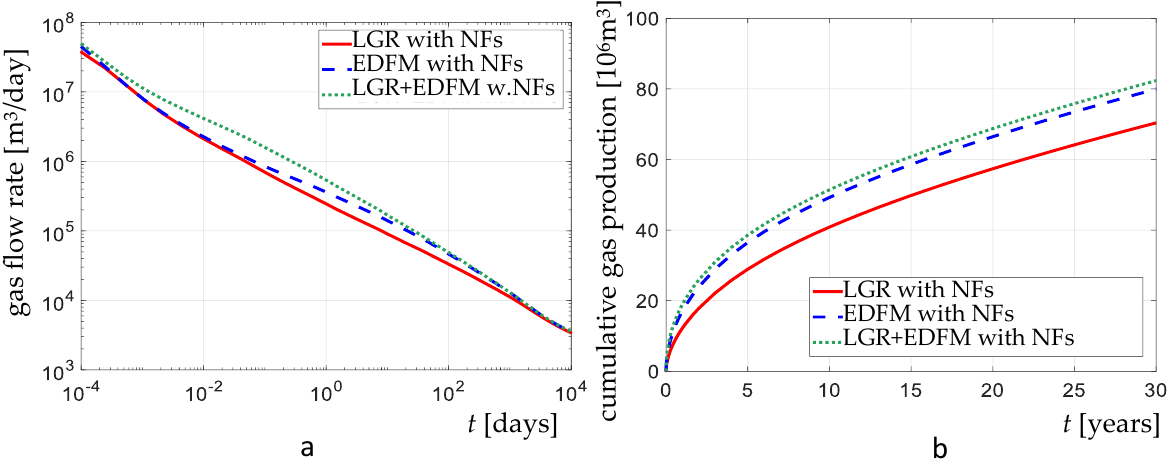
Figure 16. Comparison of the results provided by using the different grids in terms of ( a ) gas flow rate and ( b ) normalized cumulative gas production, for VE1C.